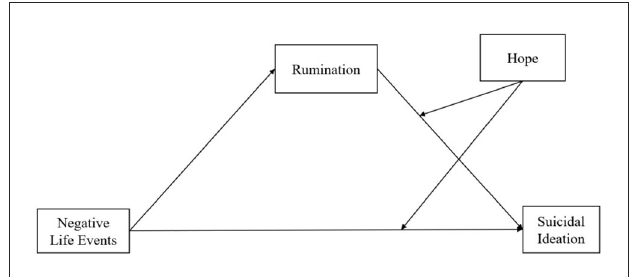
FIGURE1 Theoretical hypothesis model-moderated mediation